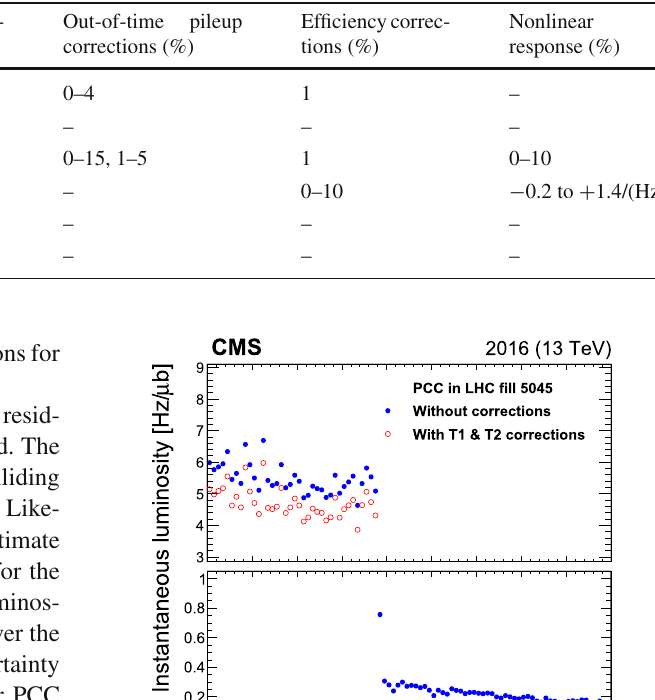
Table 2 Summary of the rate corrections under physics running condi- tions in 2016 applied separately to each luminometer. For HFOC, two distinct sources of out-of-time pileup corrections are provided. In the first and second columns, the vdM calibration condition and the relative